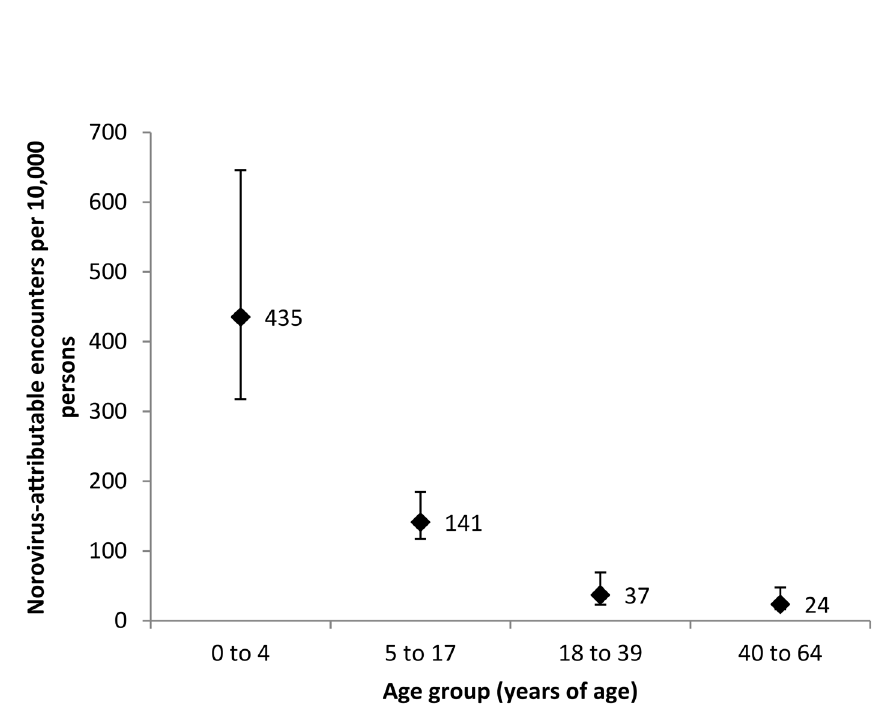
Fig 3. Median seasonal year norovirus-attributable encounters per 10,000 beneficiary persons by age group (with ranges), July 2001 – June 2011.